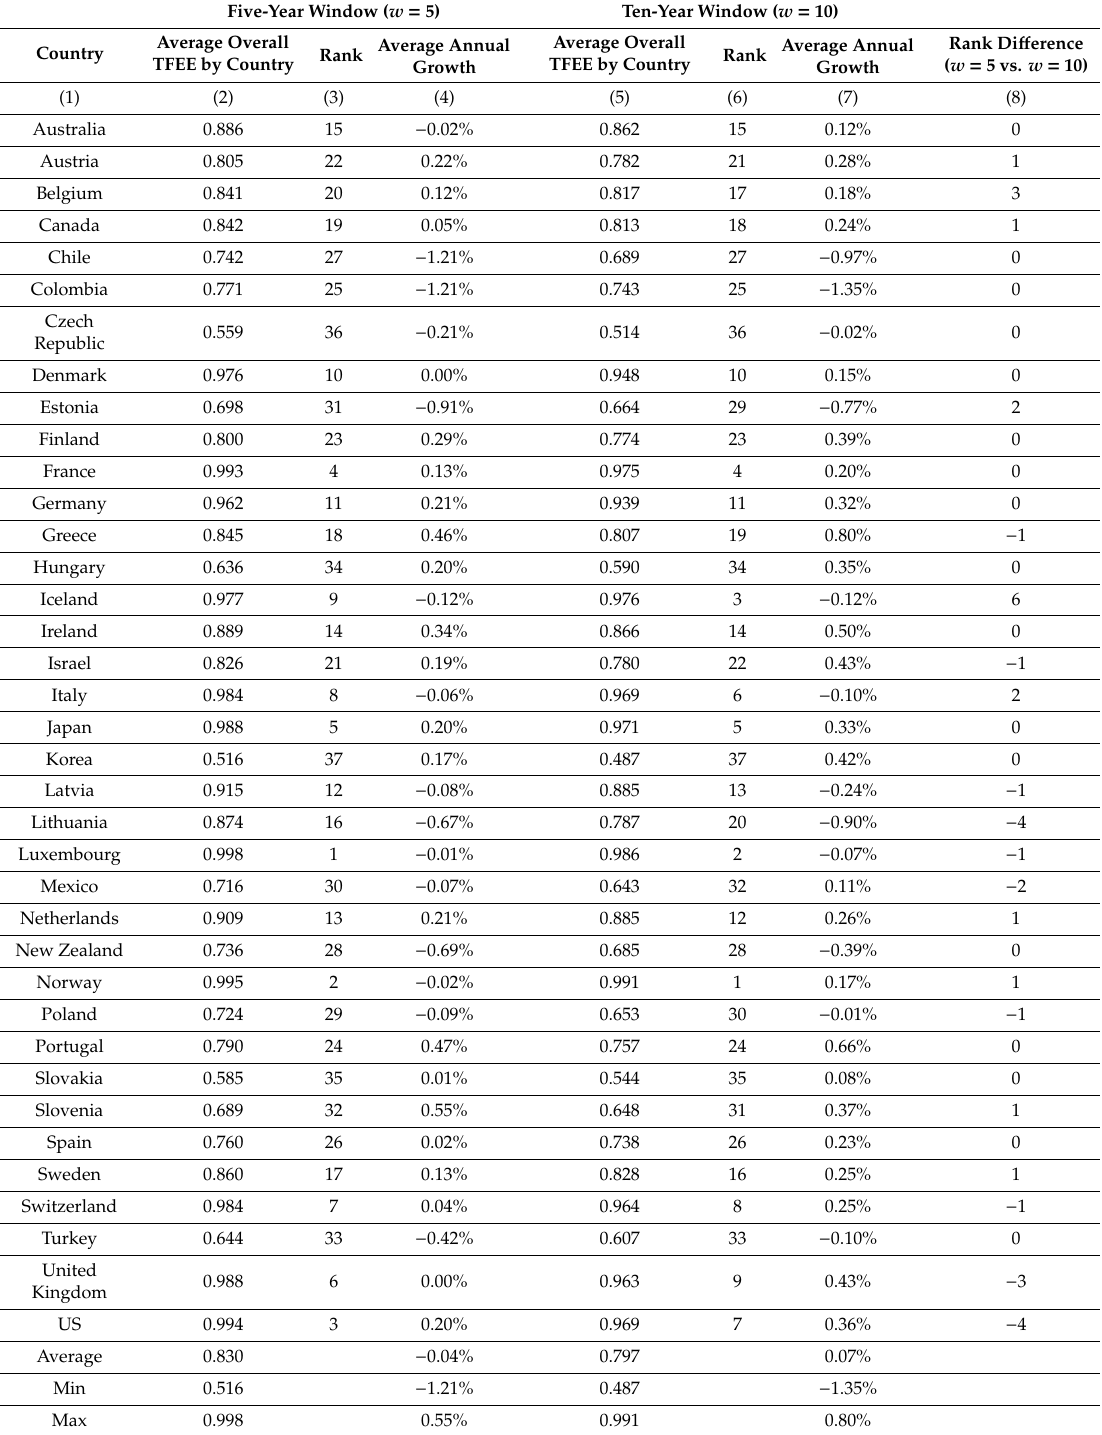
Table 4. Analytics of